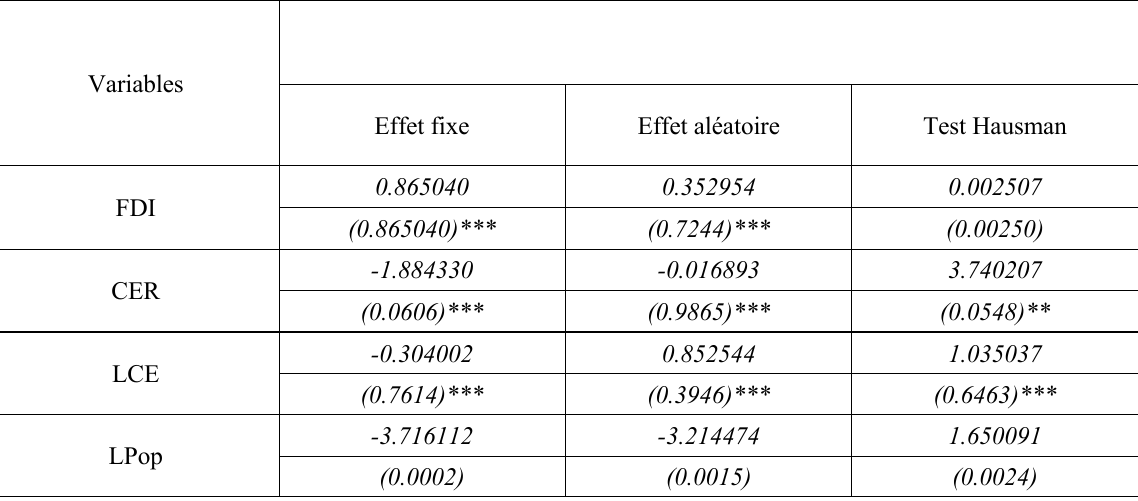
Table 5. Results of individual effect models